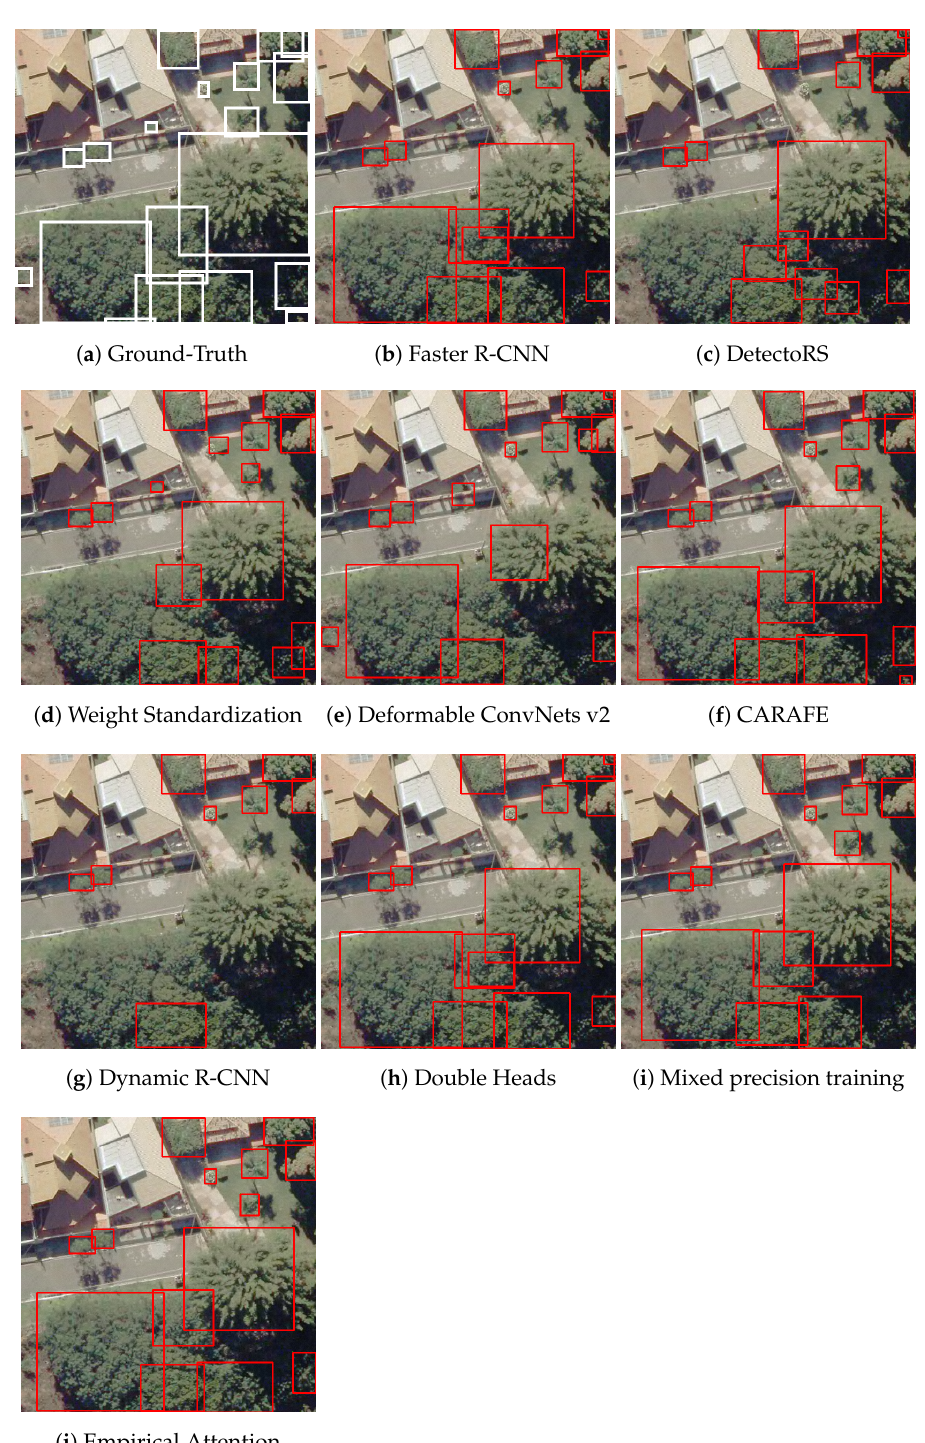
Figure 8. Examples of tree detection in areas with high density using the two-stage